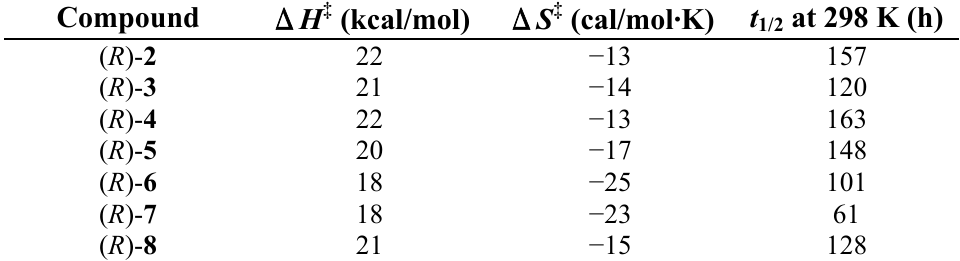
Table 3. Enthalpy of activation, entropy of activation, and half-life of ( R )- 2 - 8